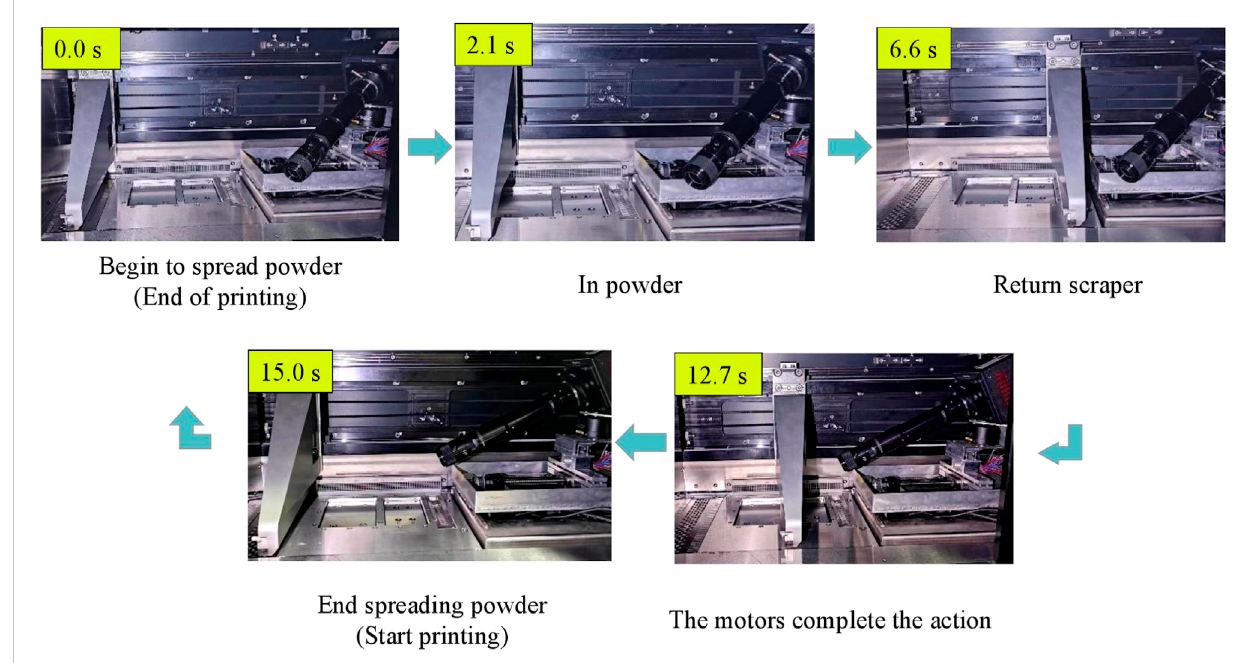
FIGURE 14 The monitoring device and SLM device are shown in different stages of collaborative control.